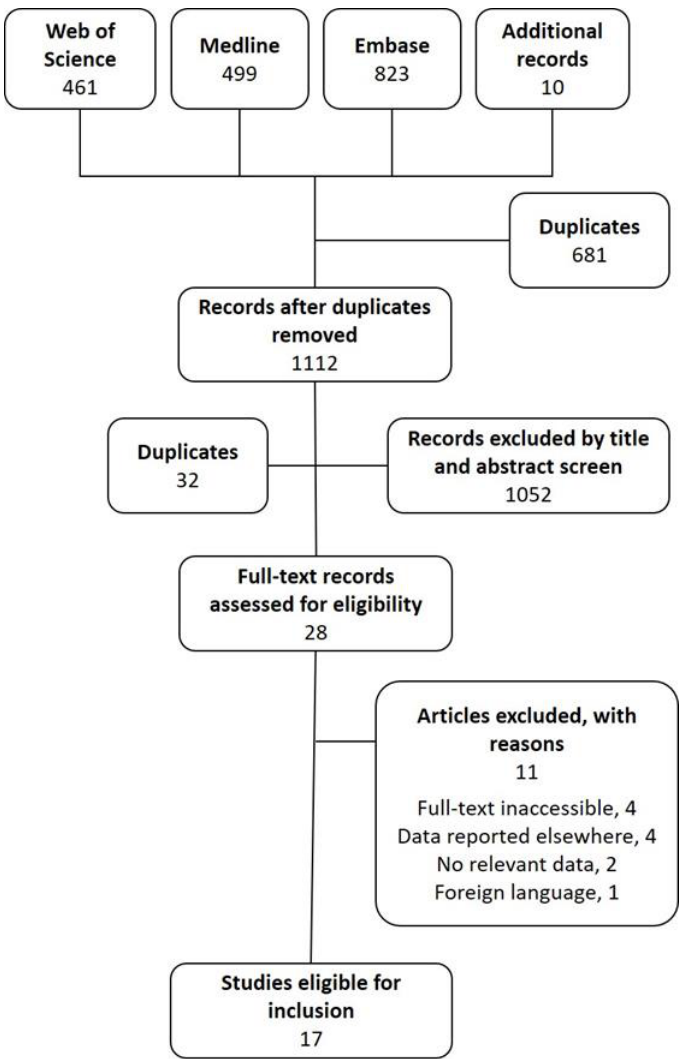
Figure 1. Flow diagram of study selection.